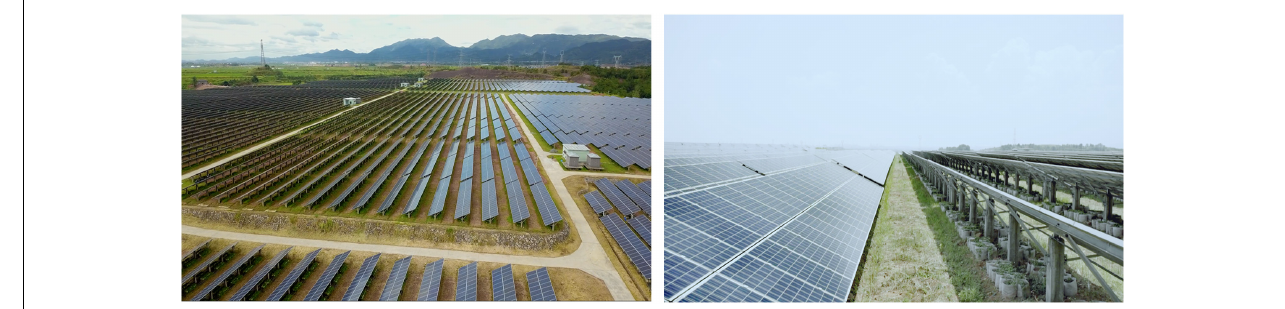
FIGURE 1 | The photovoltaic planting base of Zhejiang Guangsheng Group Co., Ltd. for planting Tetrastigma hemsleyanum